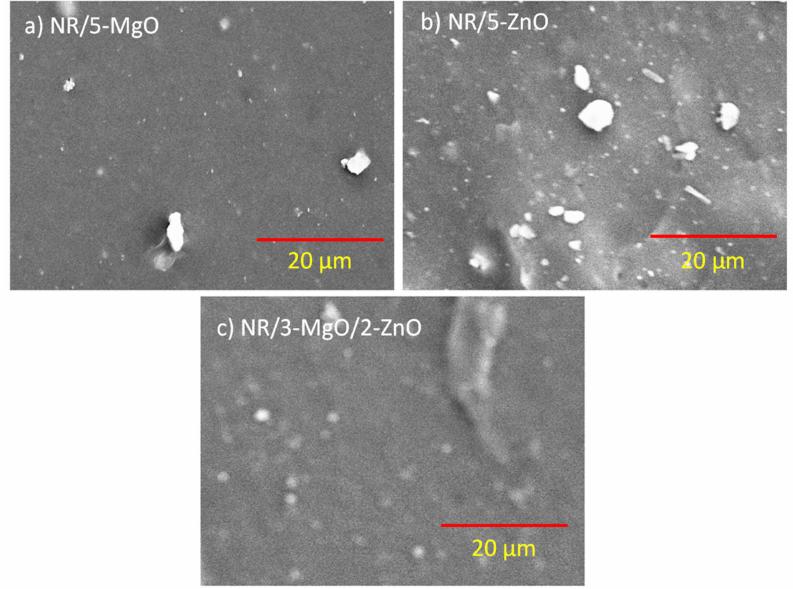
Figure 7. SEM micrographs of vulcanized rubber; ( a ) NR/5-MgO, ( b ) NR/5-ZnO, and ( c ) NR/3- MgO/2-ZnO.